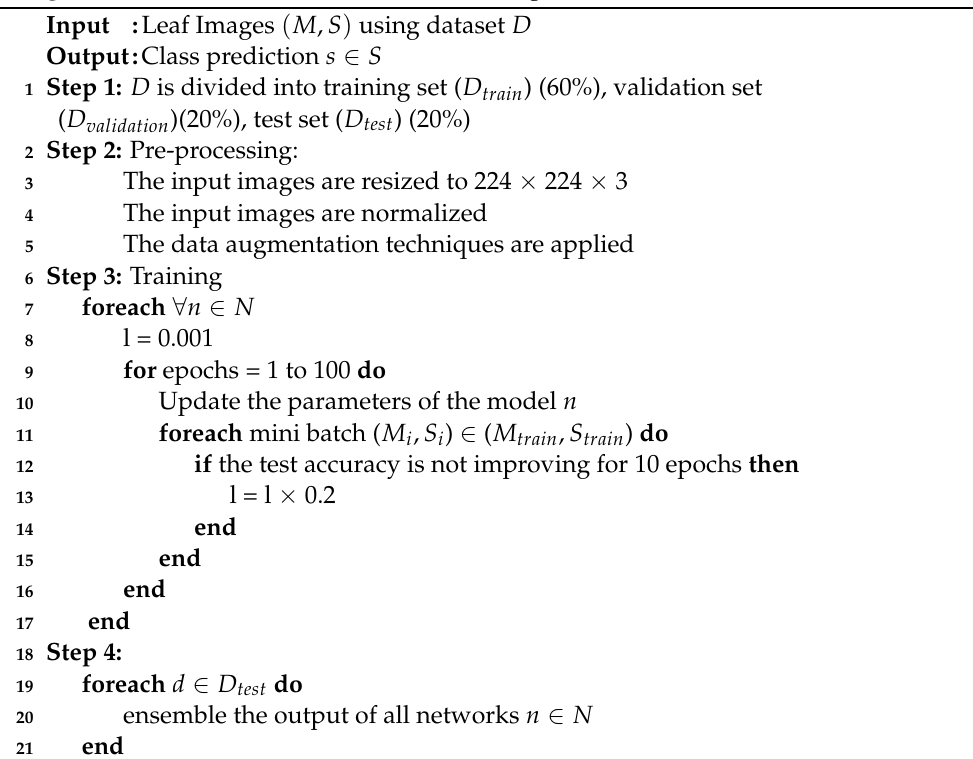
Algorithm 1: The detailed illustration of the